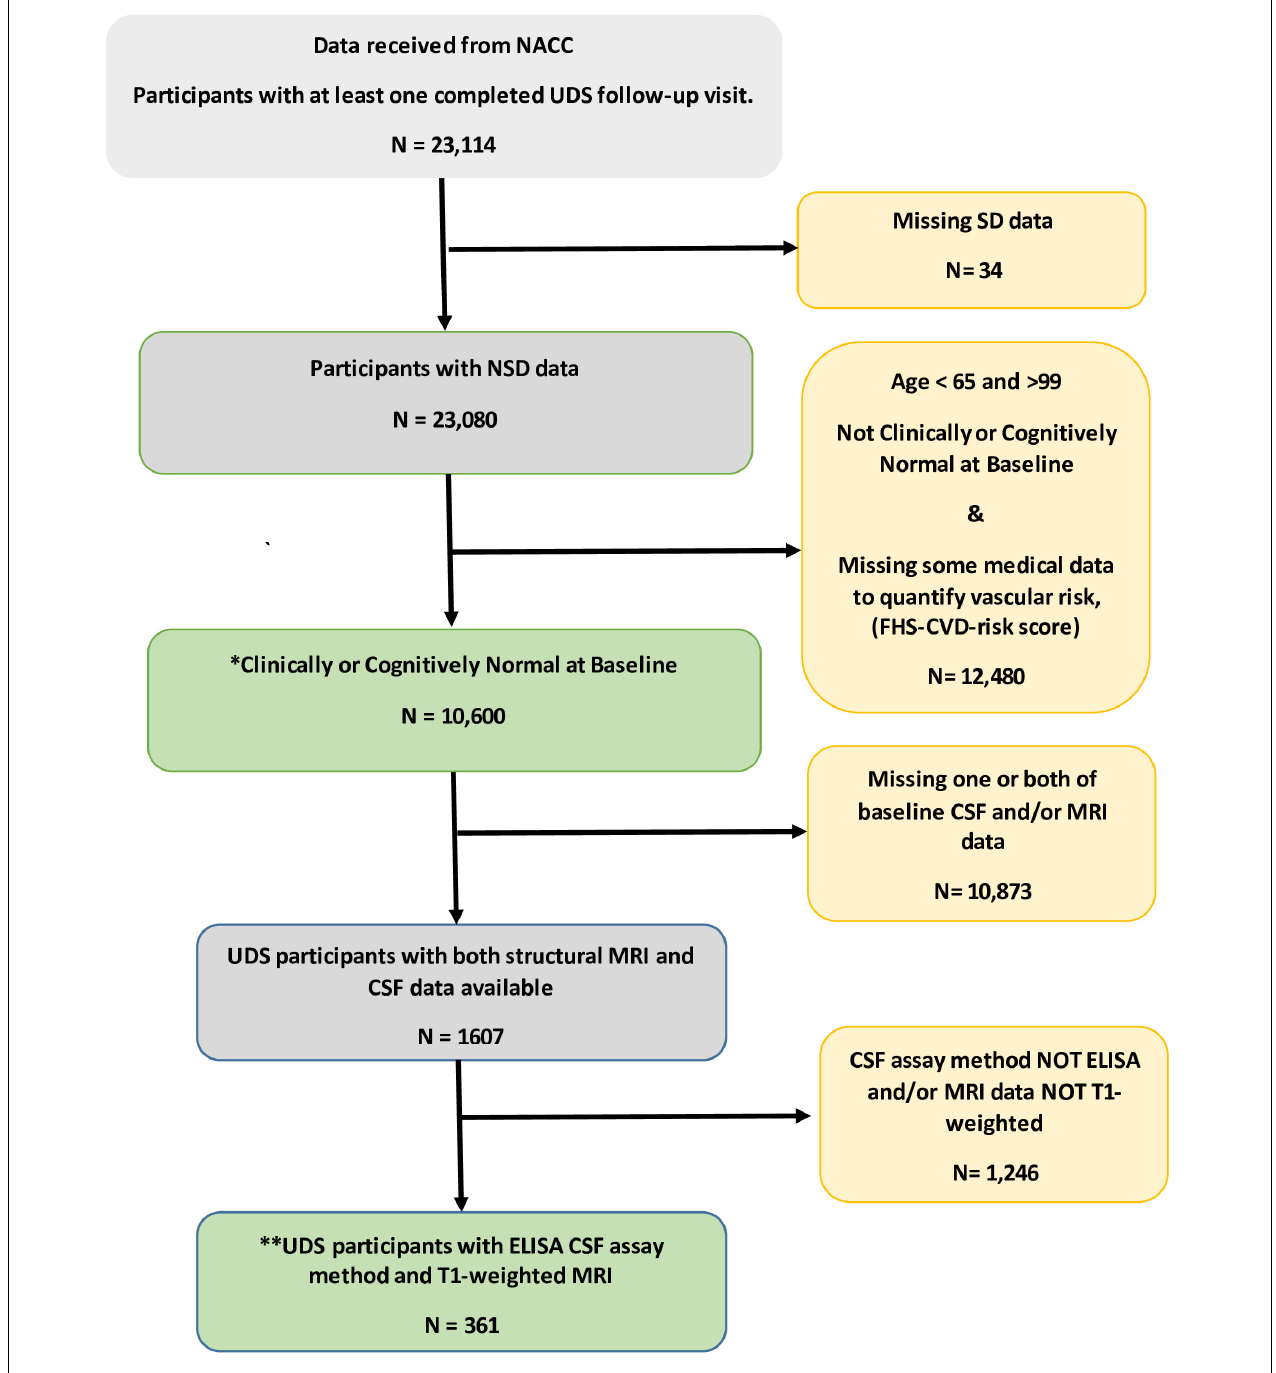
FIGURE 1 | Flowchart for the selection of subjects in the study. ∗ This group of participant data was used to examine independent and combined effects of sleep disturbance (SD) and vascular risk factors on prospect cognitive decline. ∗∗ Data from this subset were used to evaluate the unique influence of the SD/FHS-CVD risk score combined risk on prospective cognitive decline beyond that of established AD biomarkers. CSF, Cerebrospinal fluid; ELISA, enzyme linked immunosorbent assay; MRI, magnetic resonant imaging; NACC, National Alzheimer’s Coordinating Center; SD, sleep disturbance; UDS, uniform dataset.